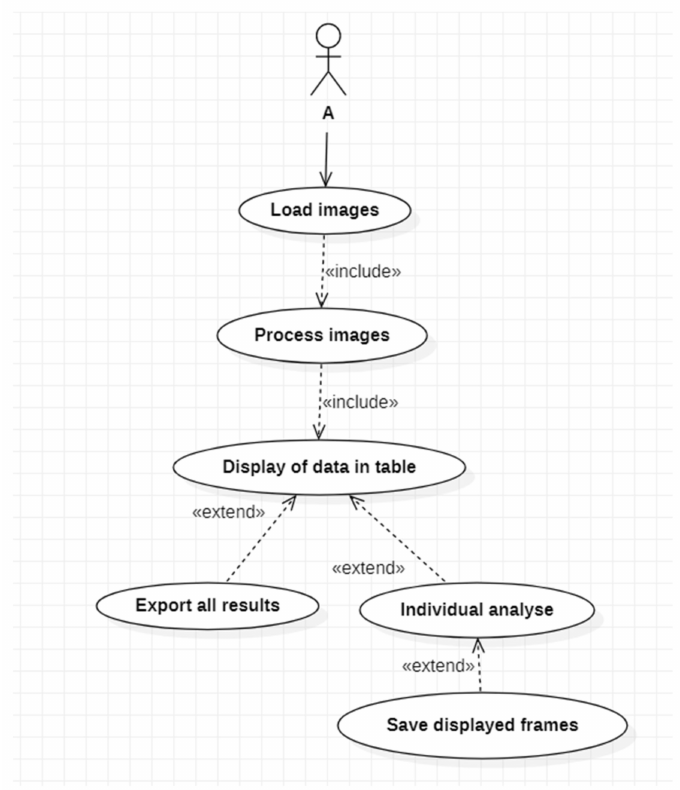
Figure 15. Use case